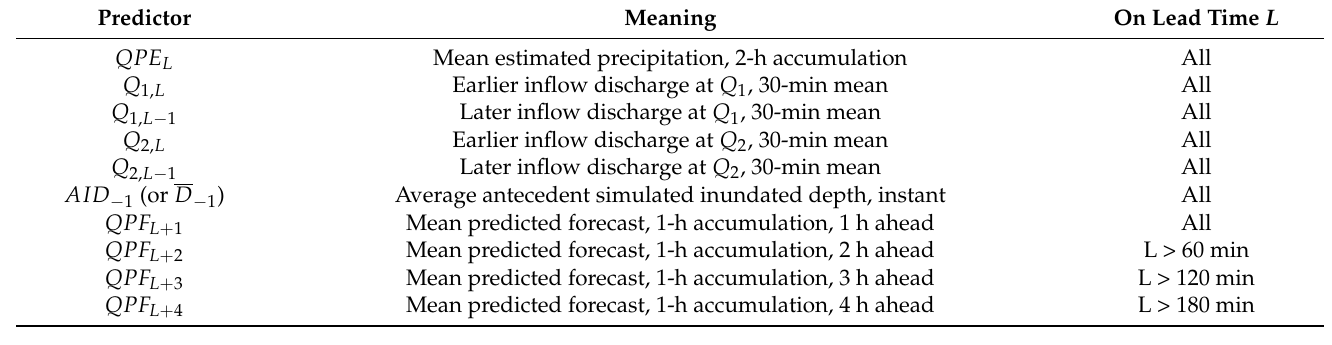
Figure 5. Distribution of the records in the training/validation dataset assigned to different topolog- Table 3. Listing of all potential NARX predictors. ical nodes for multiple configurations of SOM dimensions. Diamond markers indicate the median of each distribution.